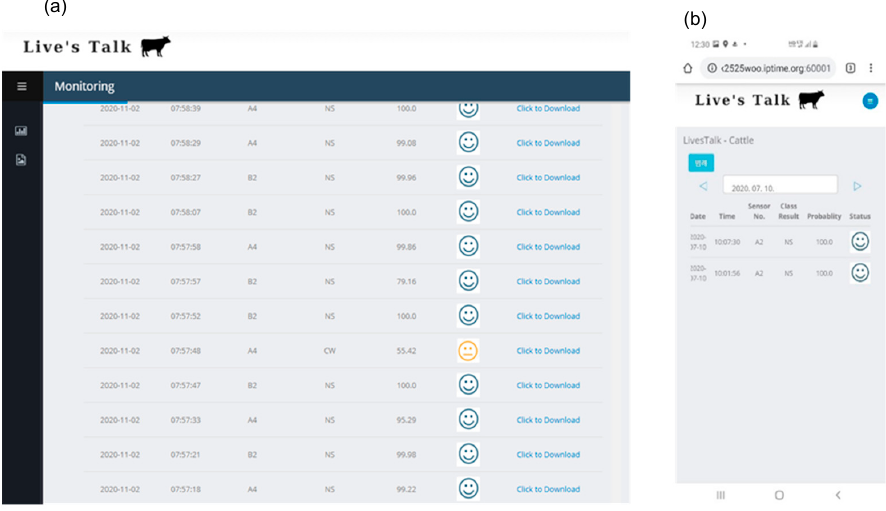
Figure 14. Sound monitoring analysis: WEB UI appearance (a) and mobile view (b).